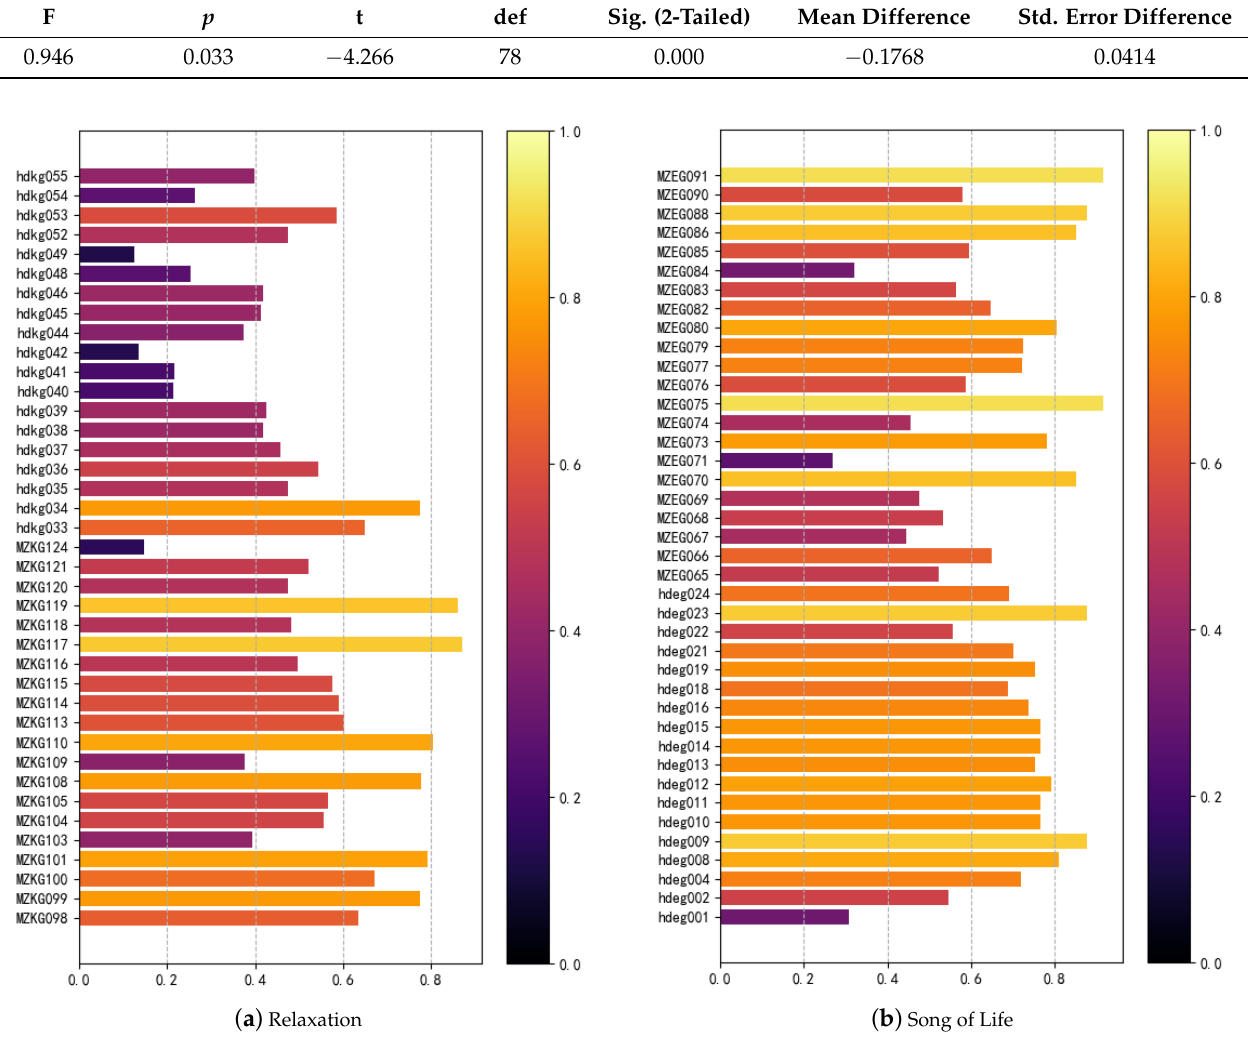
Figure 2. The evaluation score of